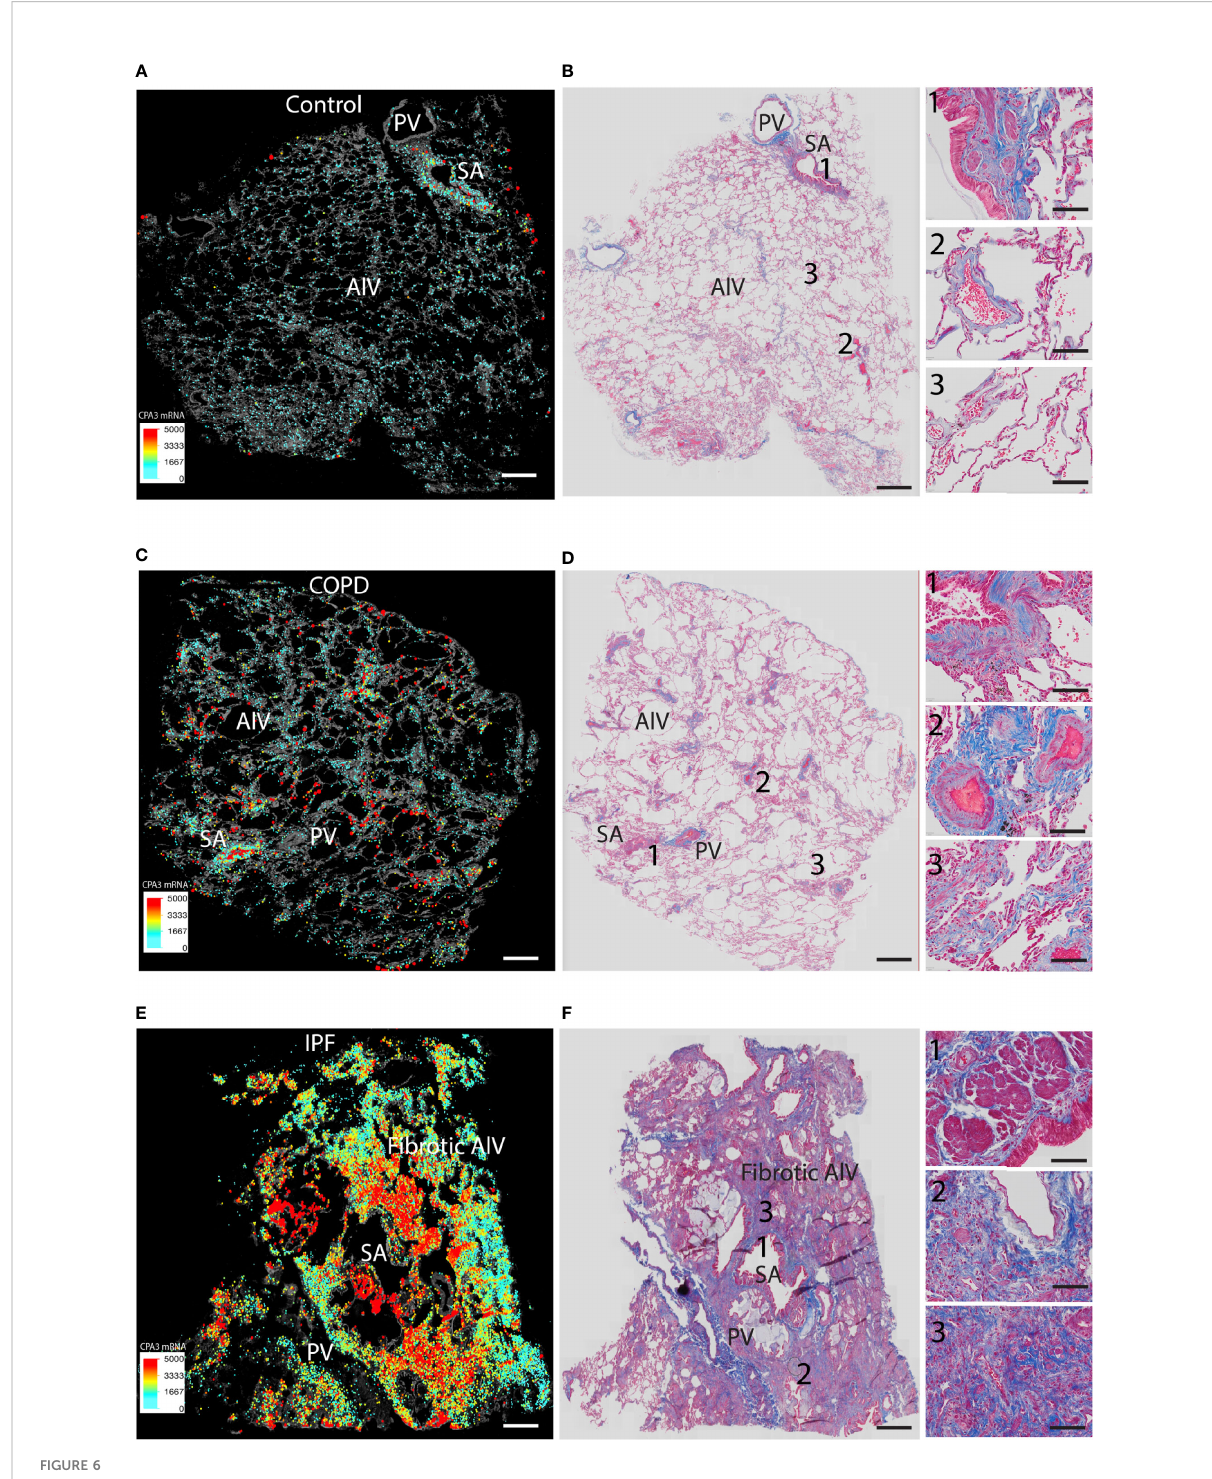
FIGURE 6 Comparisons of density-weighted and spatial CPA3 variations and lung structure in non-diseased control tissue, COPD lungs, and IPF. (A, C, E) Low-power section overviews with gray-scale tissue background in control lung (A) , COPD (C) , and IPF (D) where x , y coordinates for individual mast cells have been replaced with enlarged dots color and size coded for CPA3mRNA expression levels. (B, D, E) Corresponding serial section stained with routine trichrome staining to visualize cells (red) and collagen-rich extracellular matrix (blue) and overall lung structure. SA = small airways; PV = pulmonary vessels; Alv = alveolar parenchyma. The COPD section in (C , D) show microscopic emphysema whereas the IPF in E and F displays archetype histopathological IPF features like honeycombing, myo fi broblast accumulation, and distal parenchymal fi brosis. Scale bars: A – F = 1.8 mm, insets in B, D, F = 200 m